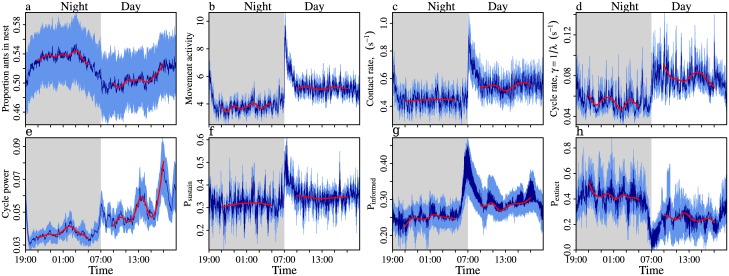
Long-term colony activity patterns.Dark and light blue time series show means and standard errors, aggregated into 1-minute time bins. Each of the 15 recording sessions contributes a single value to each 1-minute bin. Grey background shading—lights off, 20°C. White—lights on, 25°C. Red line—fit from a generalized additive mixed model (GAMM), with the time of the day (time in seconds since the lights were last switched on or off), and time-period (day/night) coded as main effects, and with colony identity (A-F) and replicate number (i,ii) coded as random effects. Due to the disturbance induced by the lights being switched on or off, the GAMM only included times in the range 21:00-05:00 and 09:00-17:00. At night there were more ants in the nest than in the day (a). (b-c) Ants moved less, and had fewer interactions at night compared to the day. (d-e) Oscillations in the interaction rate were slower and weaker at night compared to the day. Note, the wavelet analysis for the movement activity time-series gave identical results as that for the interaction rate. (f-h) The ant-to-ant contact network was less efficient at night compared to the day, having a lower probability of becoming self-sutaining, lower prevalence, and higher probability of loss (β = 1, μ = 0.006).